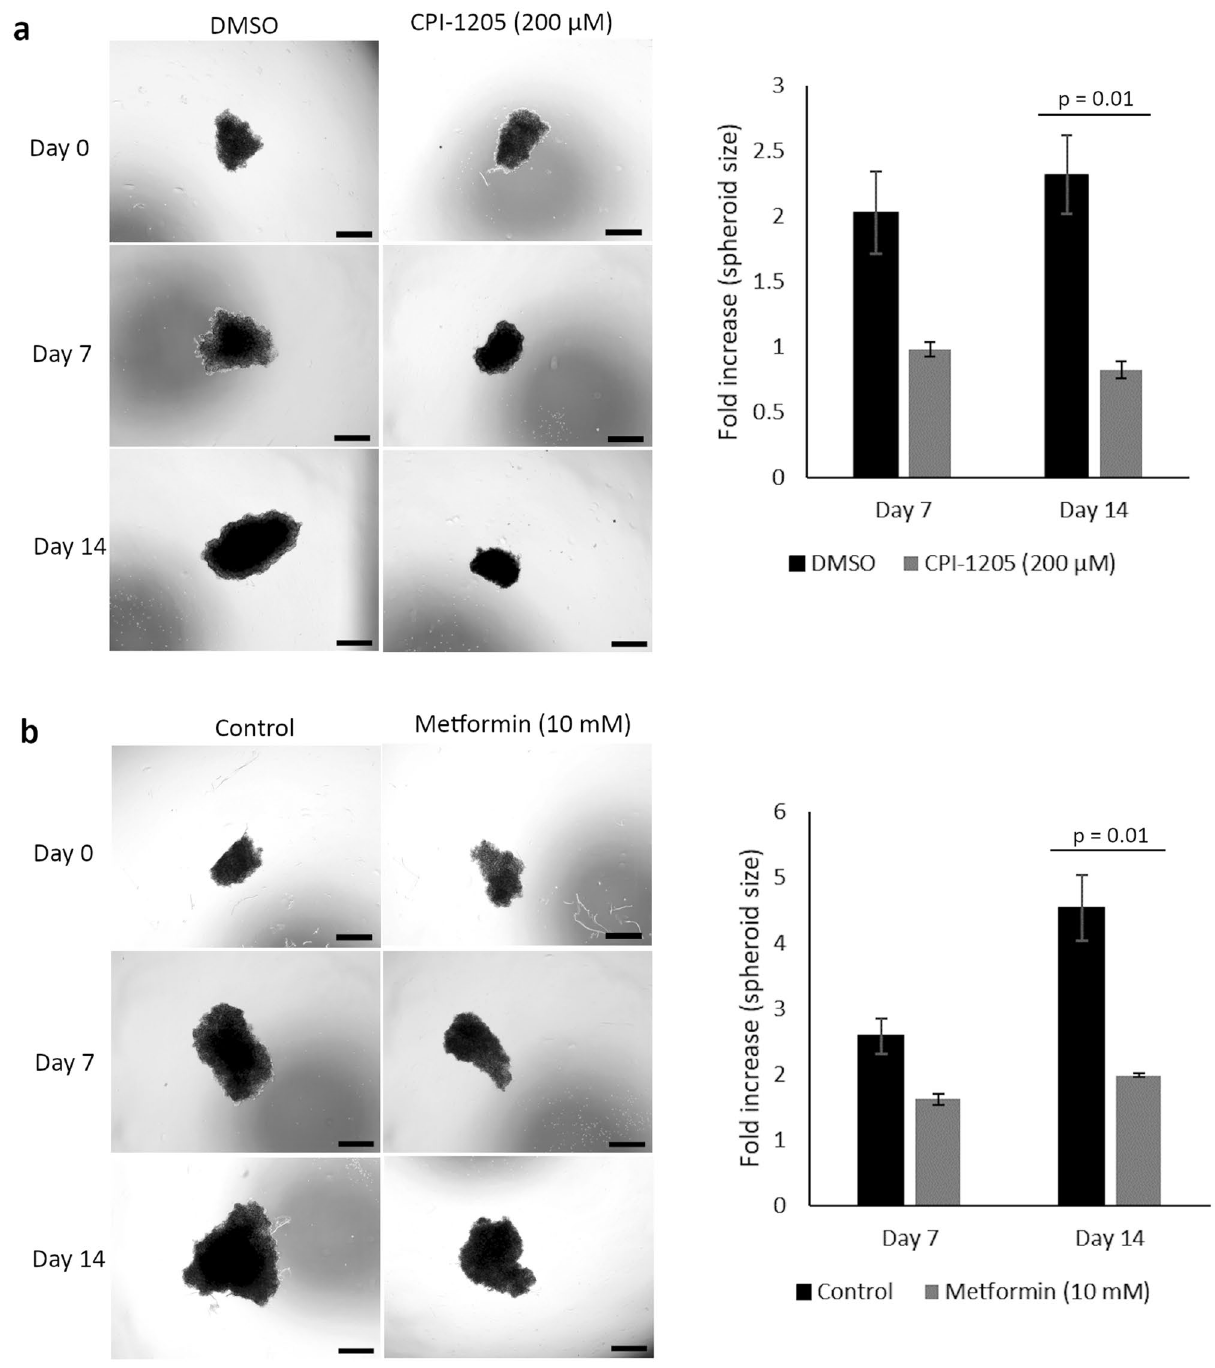
Figure 8. CPI-1205 and metformin treatment reduced the growth of GOT1 cell spheroids. Spheroids were treated with ( a ) 200 µM CPI-1205 or ( b ) 10 mM metformin for 14 days. Bright-field images were taken at day 0 of treatment, and 7 and 14 days after treatment. Scale bar 500 µm. The figure reports fold increases in spheroid size after 7 and 14 days of treatment compared to the controls. Data presented are means ± SD of